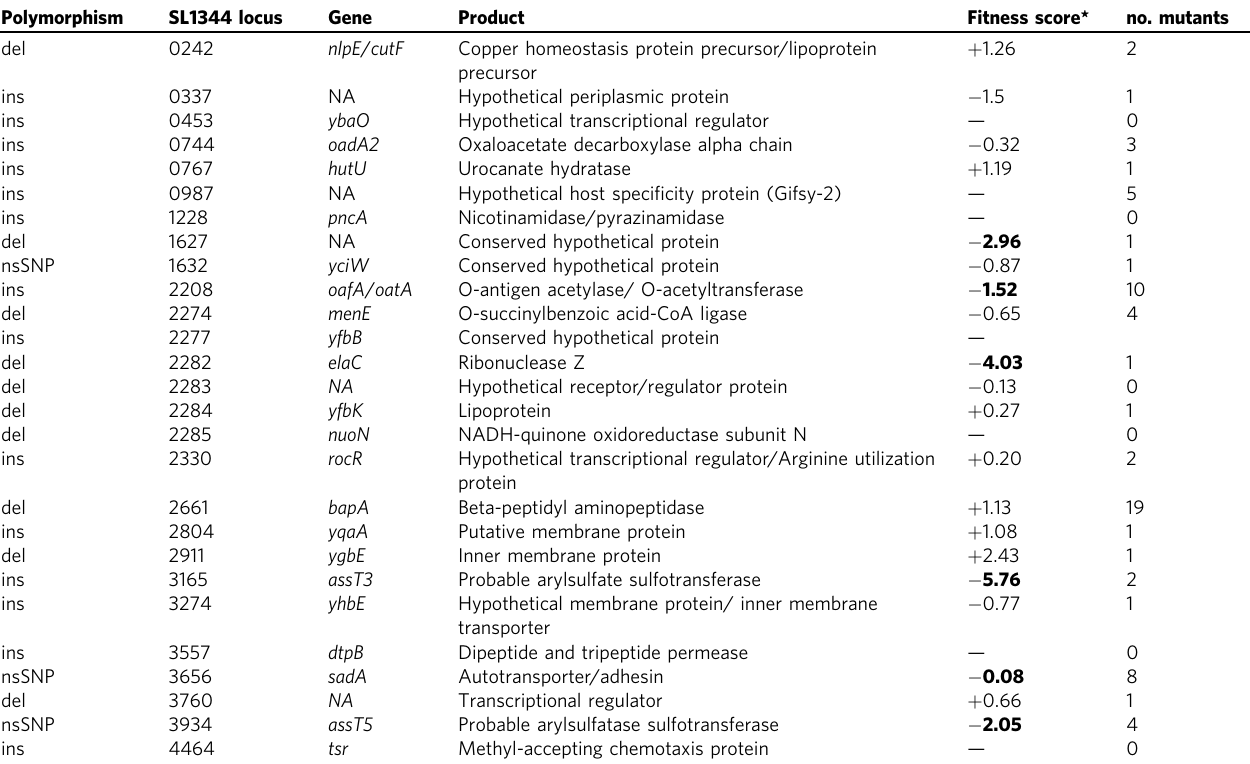
Table 1 Hypothetically disrupted coding sequence (HDCS) in U288 strain S01960-05 with reference to strain S04698-09.